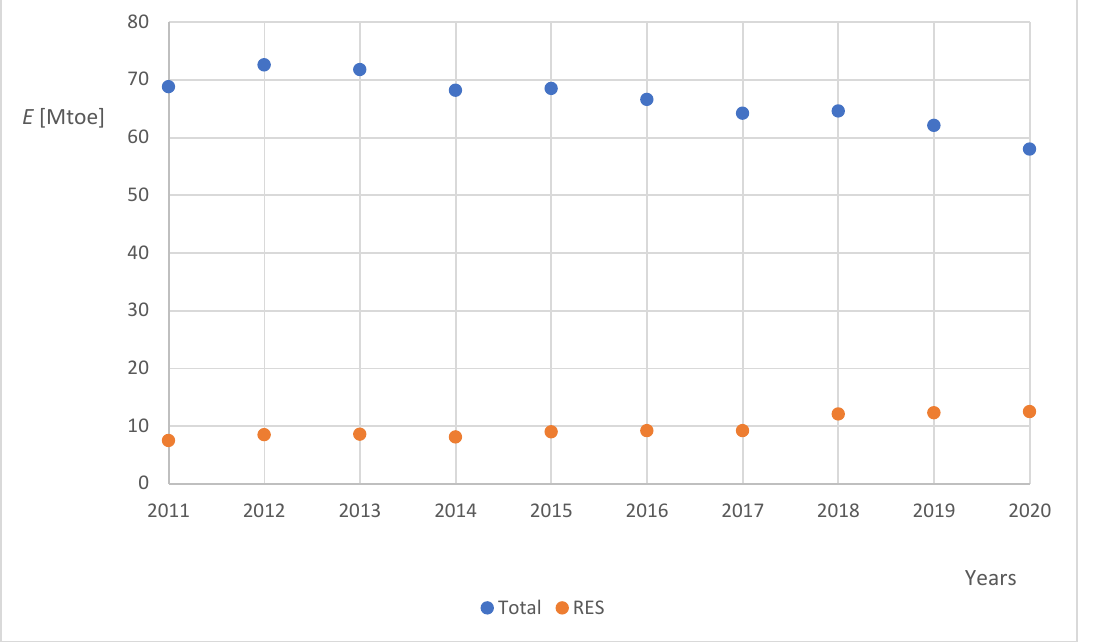
Figure 2. Obtaining primary energy, including energy from renewable sources (RES), in Poland, according to Table 18 (own elaboration).